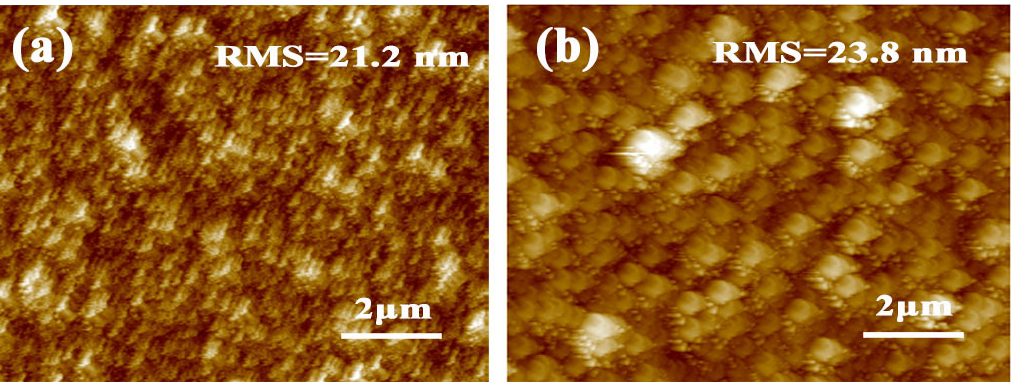
Figure 3. Atomic force microscopy (AFM) images of ( a ) bare TiO 2 NR film; ( b ) TiO 2 NR/brookite NP film.